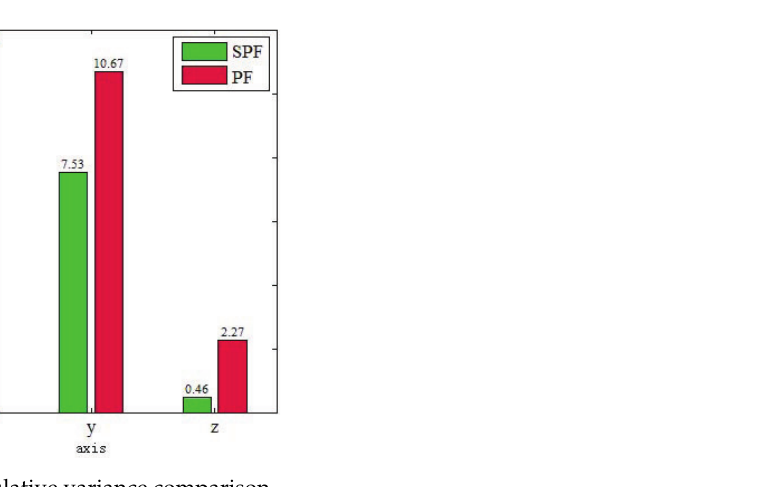
Figure 7. Cumulative variance comparison.